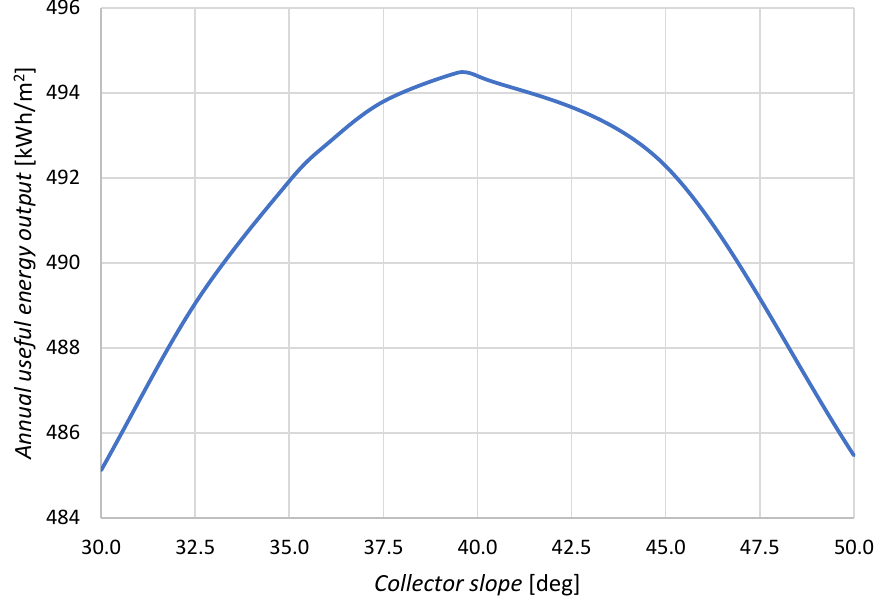
Figure 8. Dependence of the inclination angle of the solar collector on an annual useful energy output for Budapest.